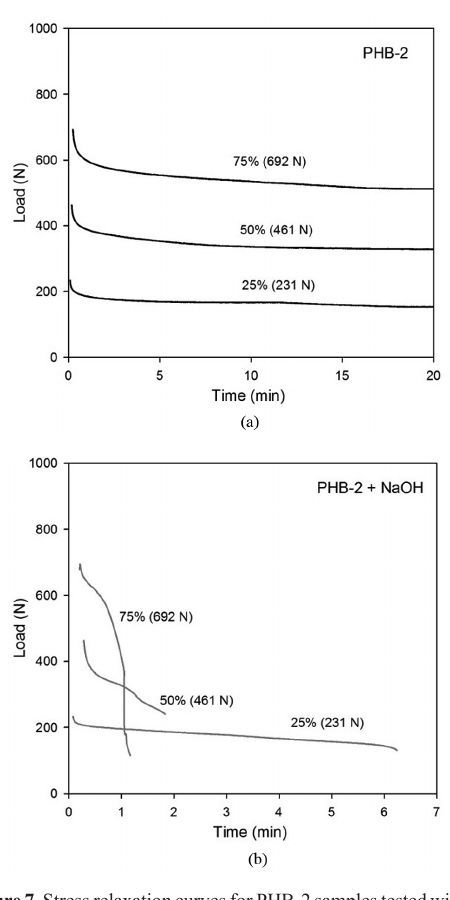
Figure 7. Stress relaxation curves for PHB-2 samples tested without (a) and with (b) NaOH.